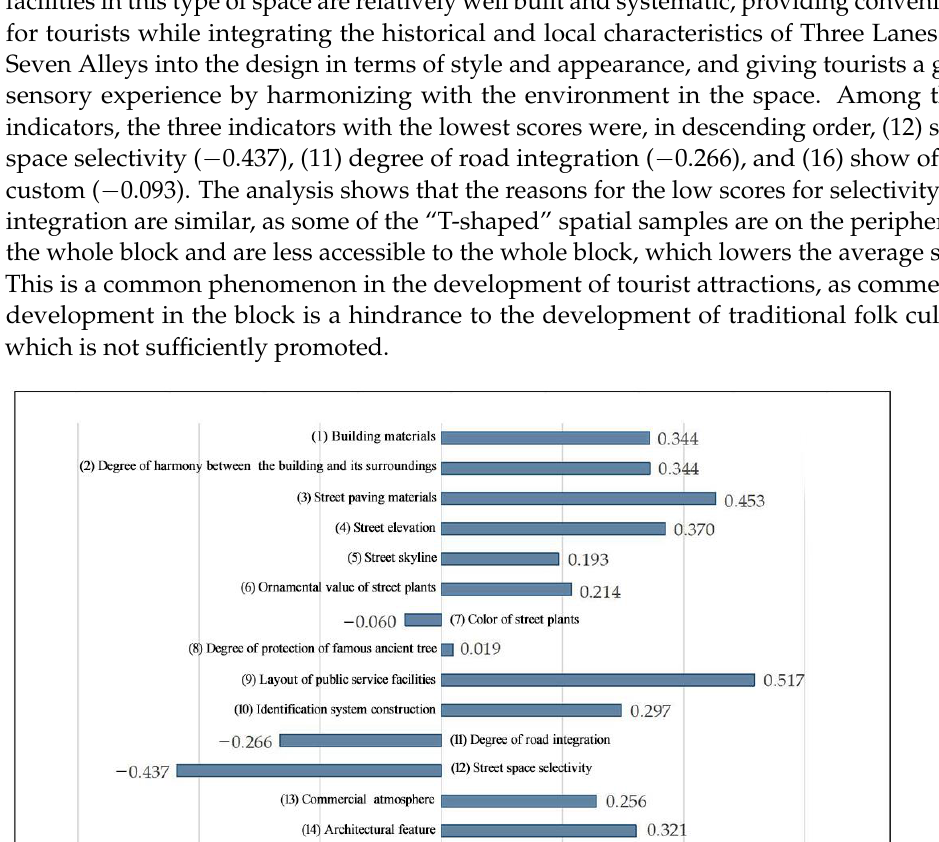
Figure 5. Evaluation values of landscape preference indicators for the “ One-character shaped ” spatial sample.